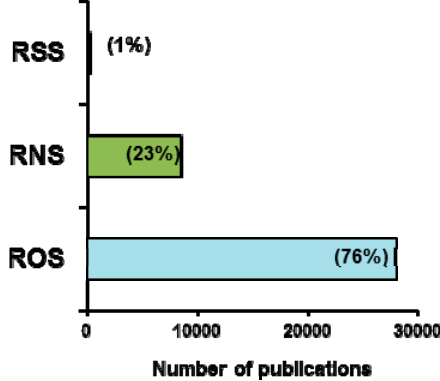
Figure 1. Number of publications related with reactive oxygen, nitrogen and sulfur species (ROS, RNS and RSS, respectively) and plants found in PubMed database.